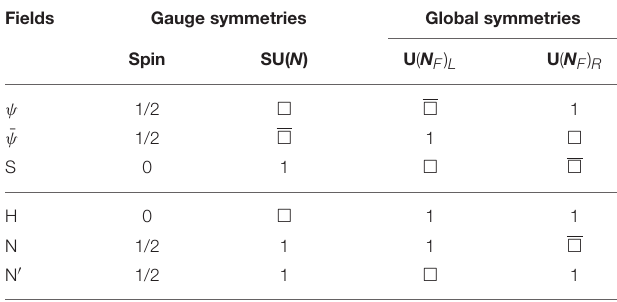
TABLE 1 | Field content of the